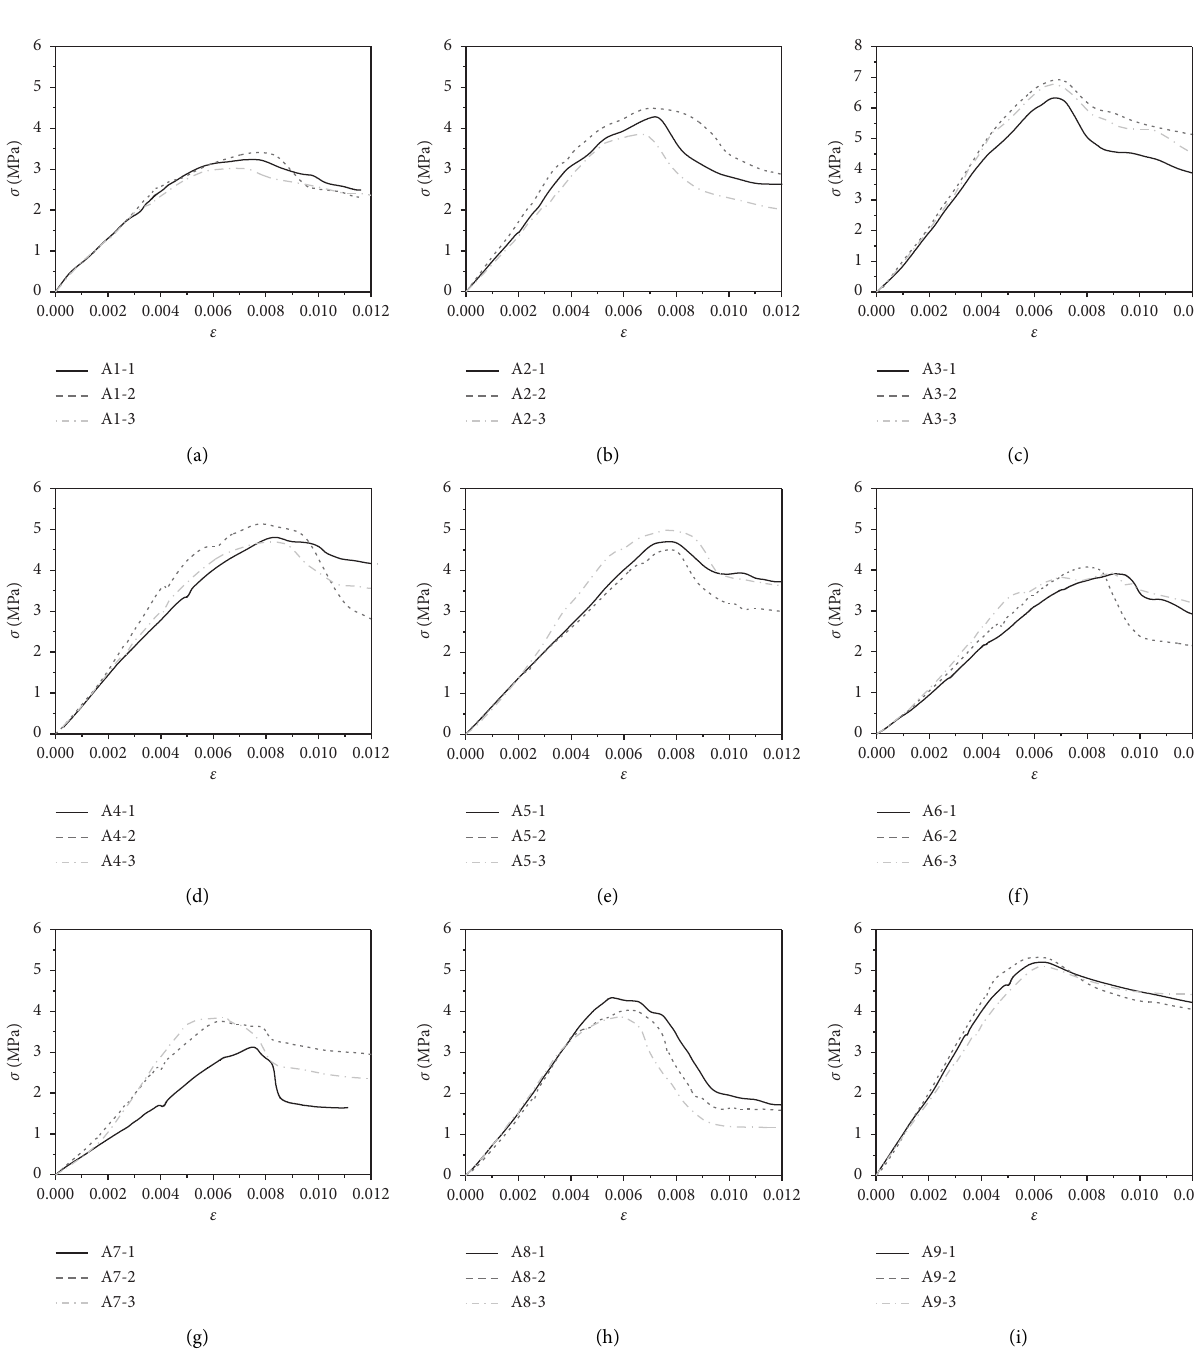
Figure 12: Stress-strain curves of